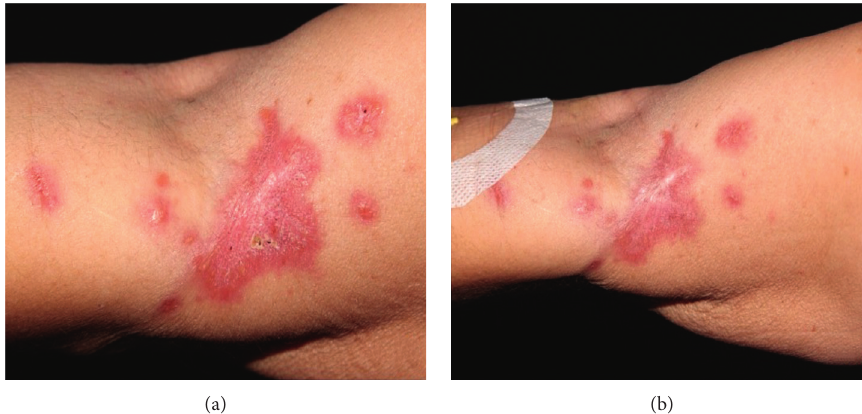
Figure 3: (a) Morphological aspect of the lesions after infusion of 150mg of amphotericin B deoxycholate and 2600mg of liposomal amphotericin B presenting re-epithelization and absence of exudate. (b) Morphology of the lesion after infusion of 2600mg of liposomal amphotericin B and 150mg of amphotericin B deoxycholate, showing complete re-epithelization of ulcerated lesions and absence of exudation.